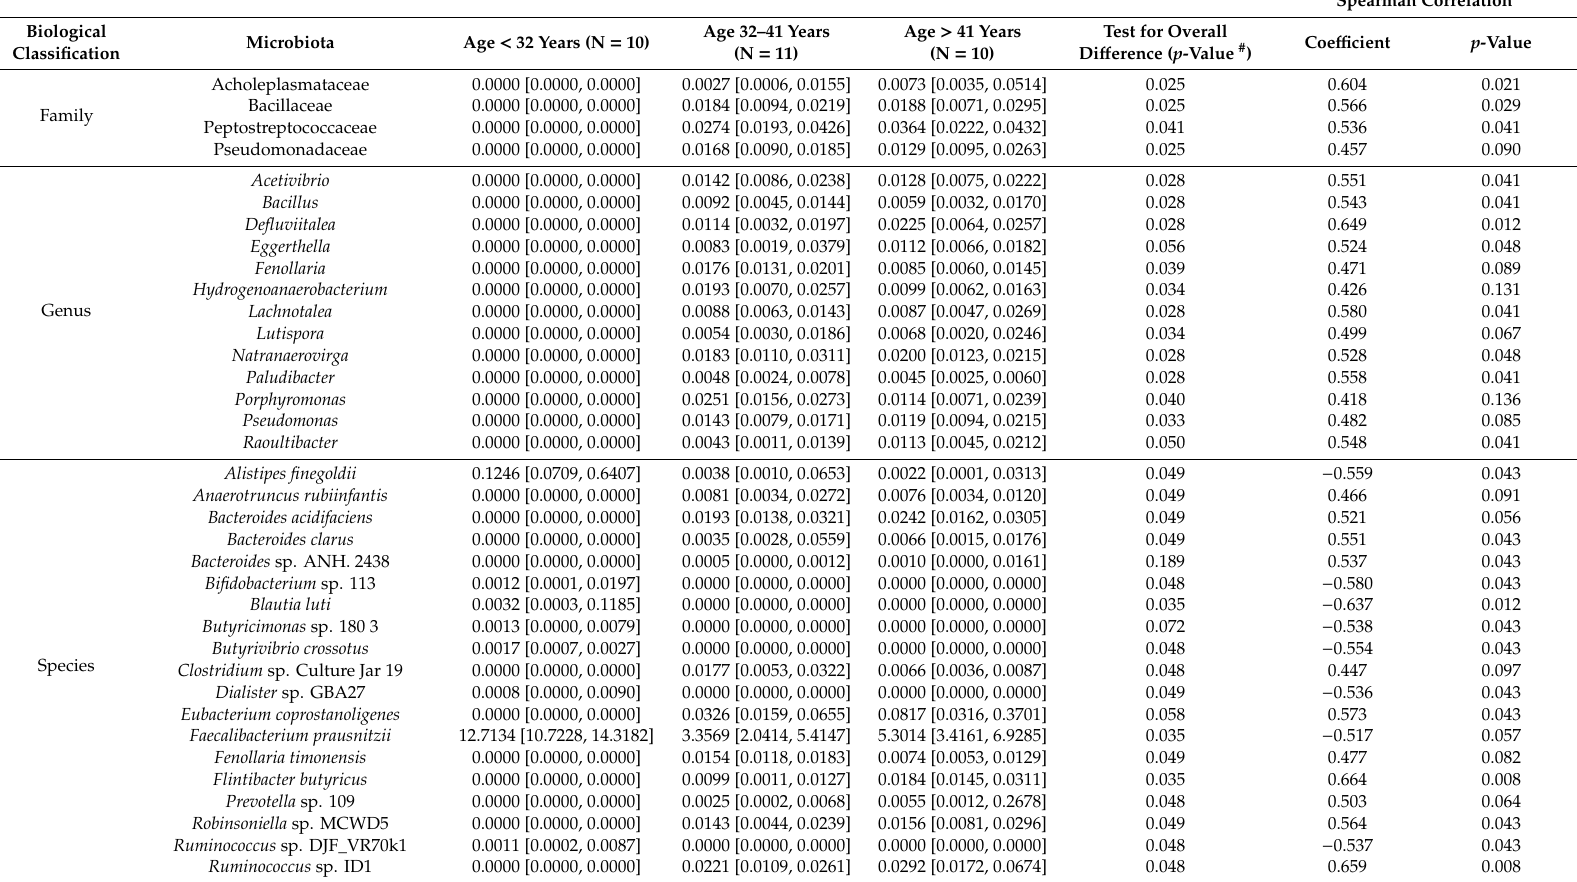
Table 2. Gut microbiota in subjects grouped by age classes (i.e., tertiles) and Spearman correlation coe ffi cients. Data were reported as median along with interquartile range (first-third quartiles). Only significant results (i.e., p -values < 0.05 from any statistical test) were reported. All p -values were adjusted controlling for the False Discovery Rate at 0.05 level within each taxonomic